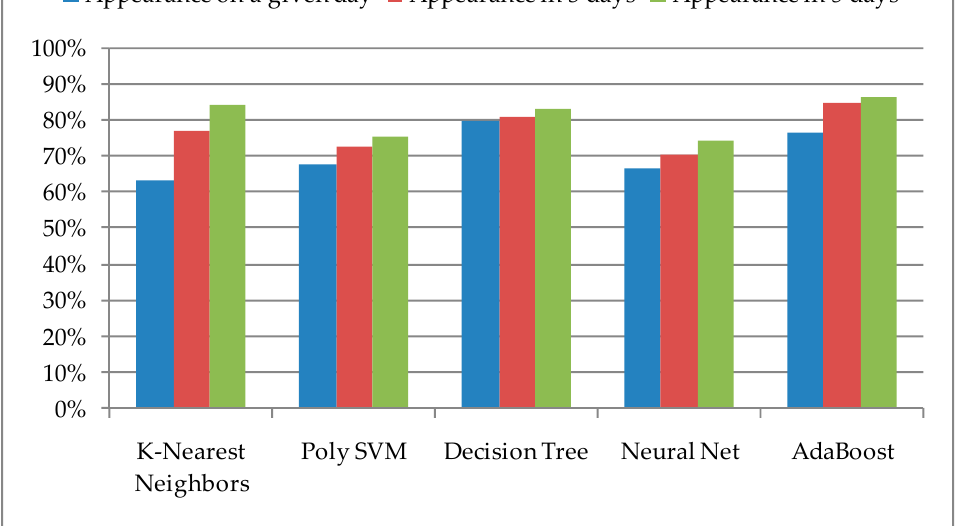
Figure 3. Prediction of the pest insect appearance according to an extended method with selected ML algorithms.